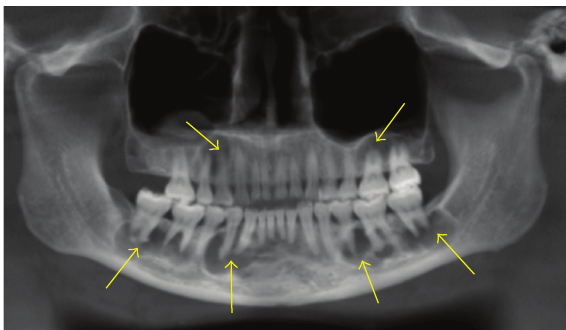
Figure 3: Florid cemento-osseous dysplasia seen as mixed predominantly radiolucent lesions seen in the periapical regions of most of the teeth in the maxillae and the mandible on this panoramic reconstruction